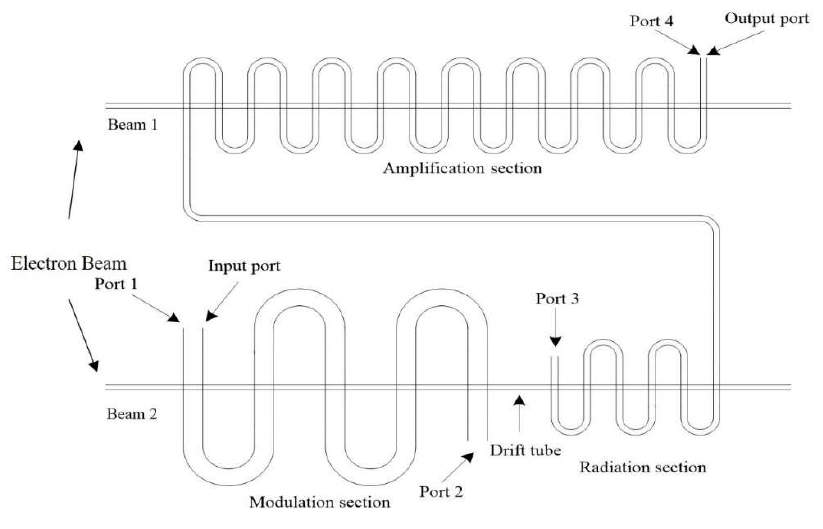
Figure 12. The SWS of the dual-beam CE-HHTWT.